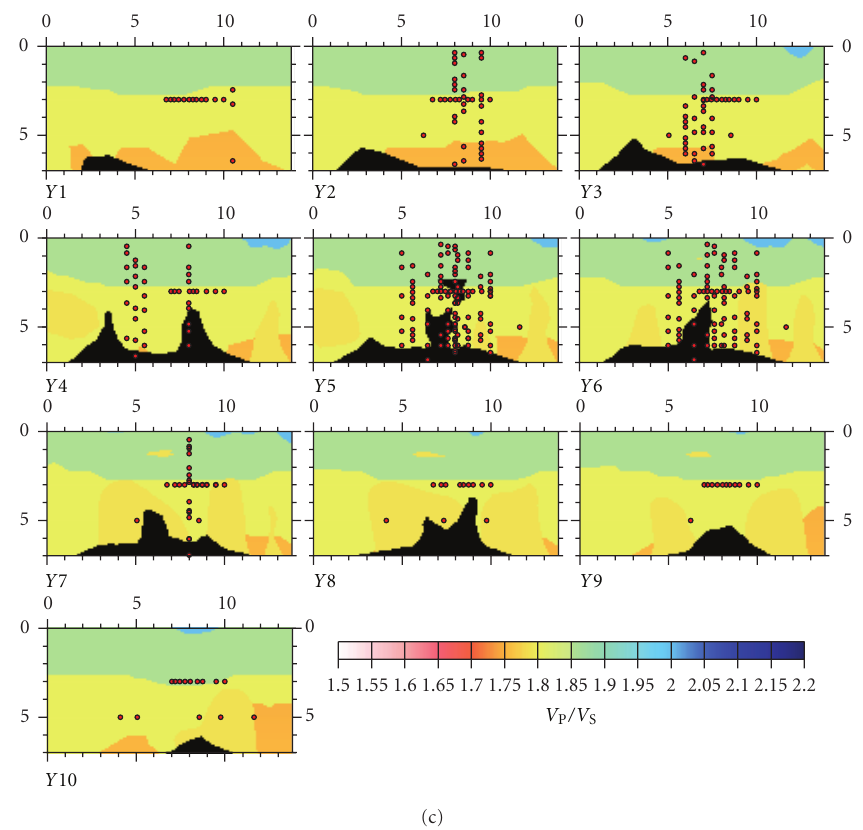
Figure 4: 3D model: V P (a), V S (b), and V P /V S (c) along vertical EW-oriented